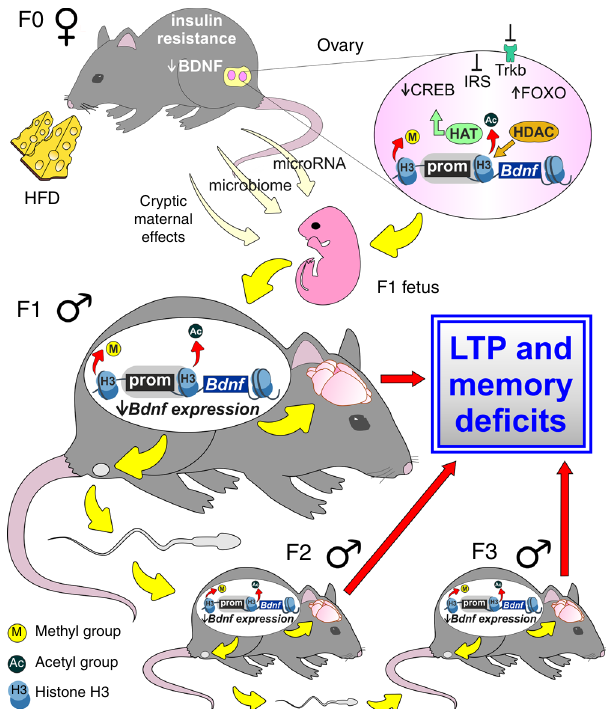
Fig. 9 Flow chart of fi ndings. Maternal (F0) HFD causes molecular and behavior changes in the offspring (F1) via gametic mechanisms involving epigenetic inhibition of Bdnf expression. Both low BDNF plasma levels and insulin resistance in mothers lead to alterations of BDNF and insulin signaling in the ovaries and change the recruitment of histone acetyl- transferases (HAT) and histone deacetylases (HDAC) on the Bdnf promoters. These epigenetic modi fi cations may be transferred from oocytes to embryo. Additional mechanisms including maternal microbiota transfer, microRNA, and cryptic maternal effects may be involved in